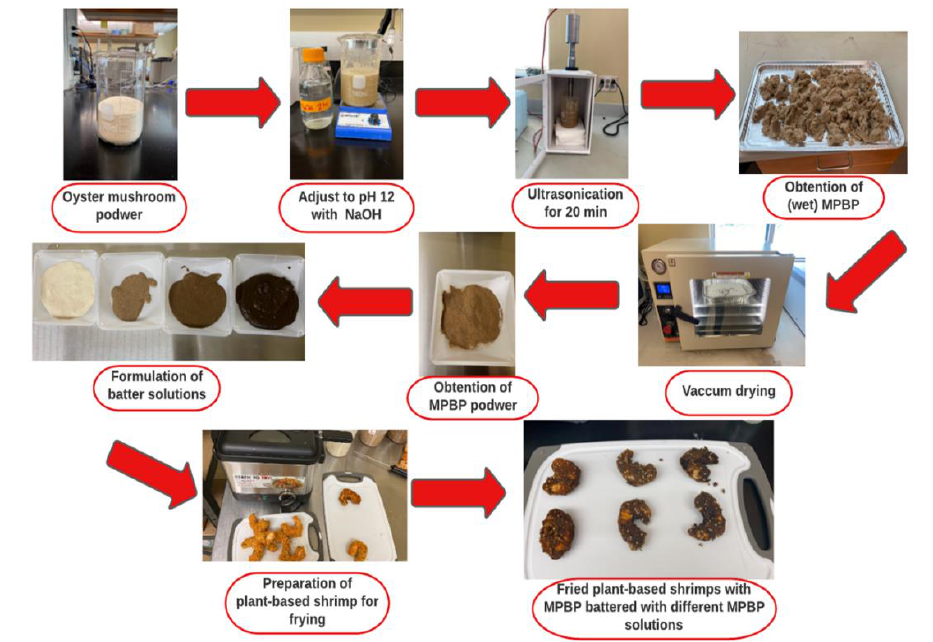
Figure 1. Processing flowchart to produce fried-batter coated shrimp coated with different batter formulations prepared with or without mushroom protein by-product.